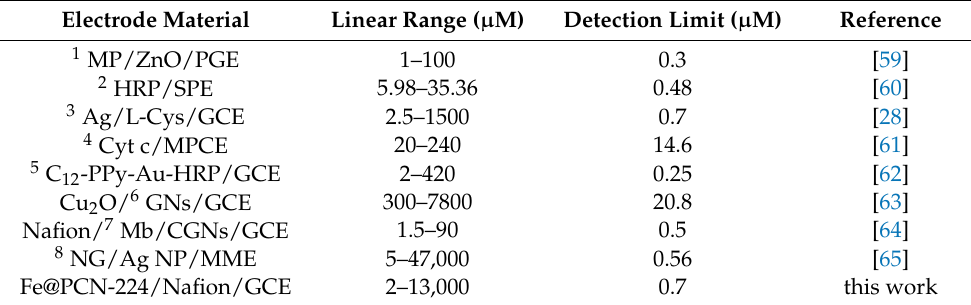
Table 1. Comparison of different sensors for the determination of H 2 O 2.